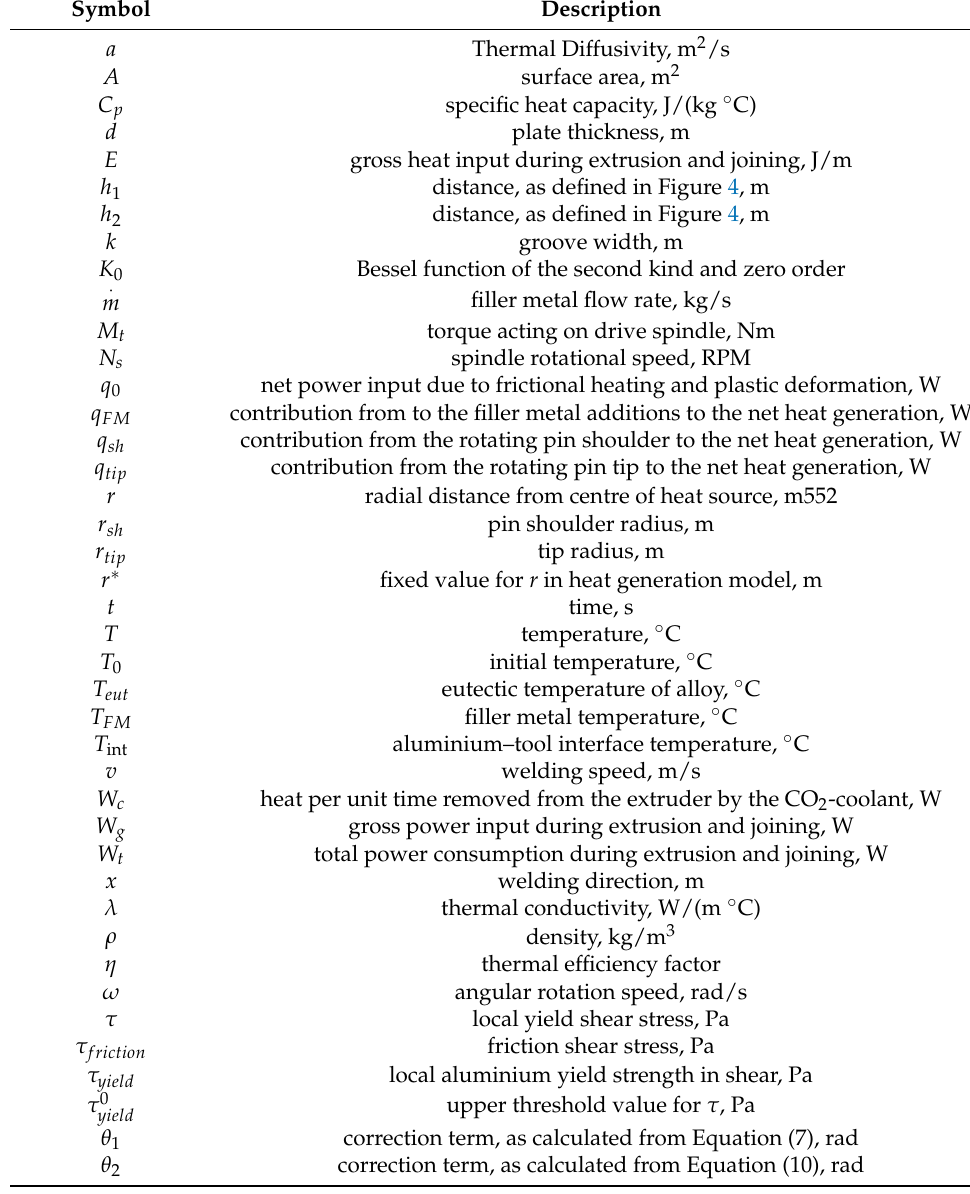
Table A2. Analysis of the sensitivity of the model outputs to variations in the τ 0